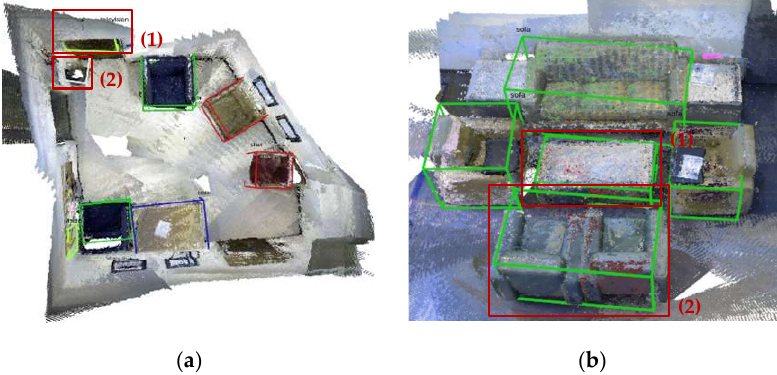
Figure 9. Some failure cases of 3D object detection on the SceneNN datasets. ( a ) sequence 011, (1) the door is recognized as a television and (2) the dustbin is recognized as a toilet; ( b ) sequence 061, (1) the